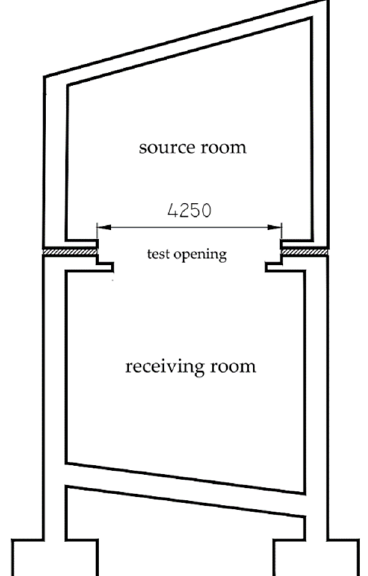
Figure 6. Vertical cross-section of the test facility.